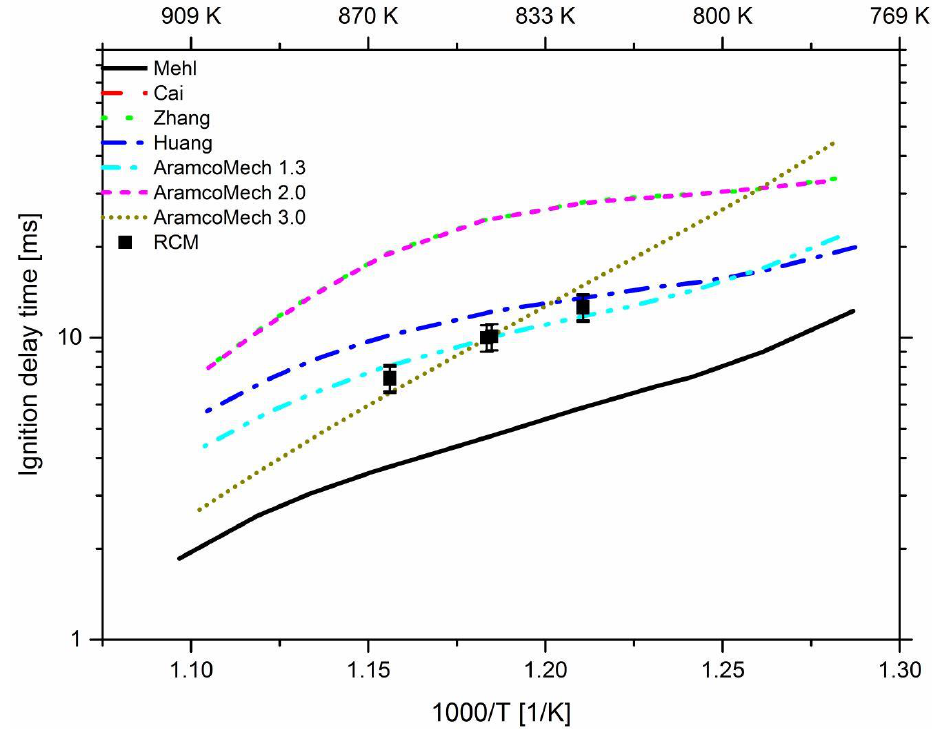
Figure 7. Experimental RCM data (symbols) [37] versus model prediction at P c = 100 bar using 70 mol % CH 4 and 30 mol % C 3 H 8 at λ = 1.9.